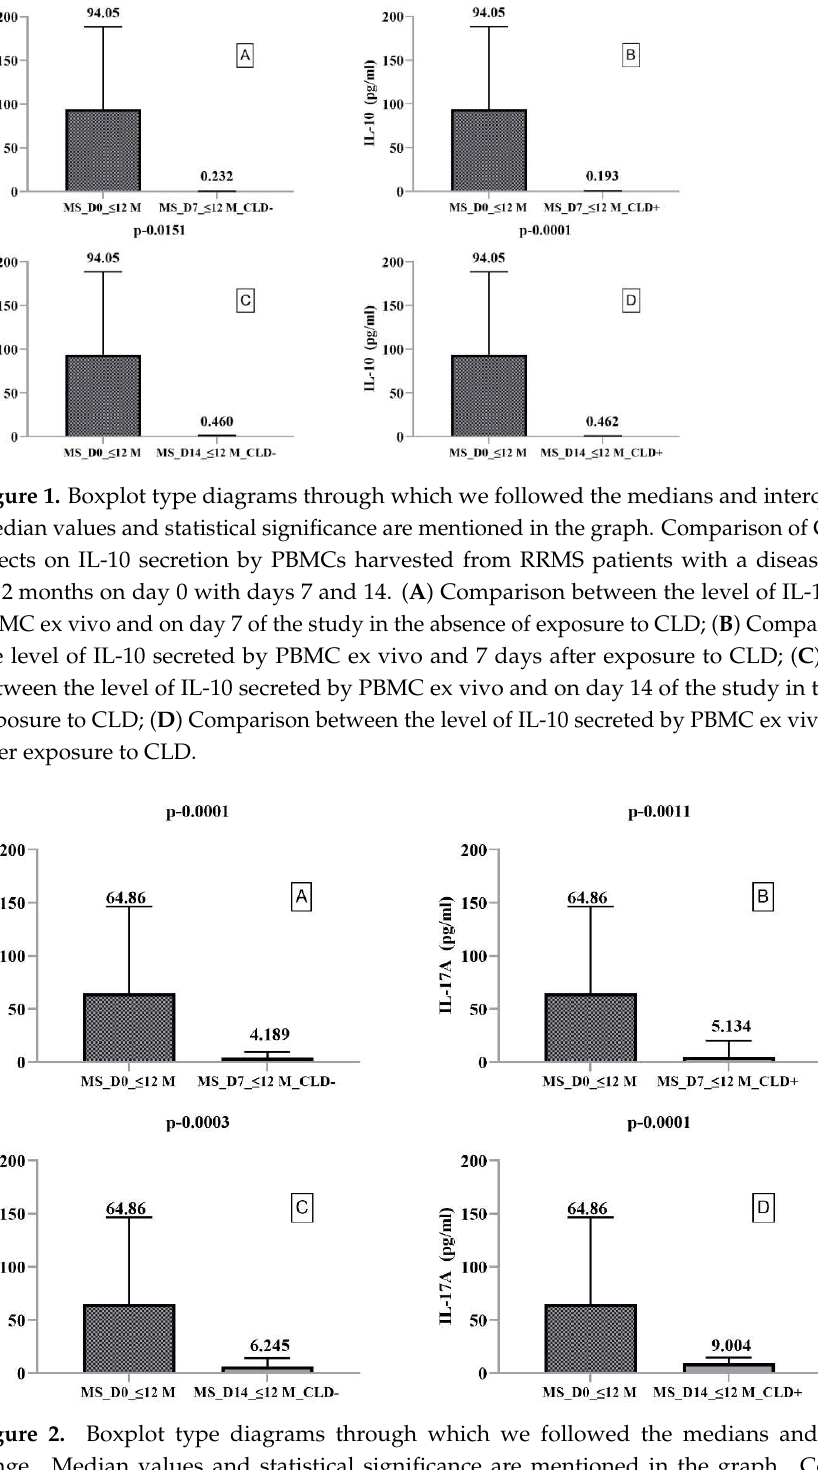
CLD exposure effects on IL-17A secretion by PBMCs harvested from RRMS patients with a disease duration of <12